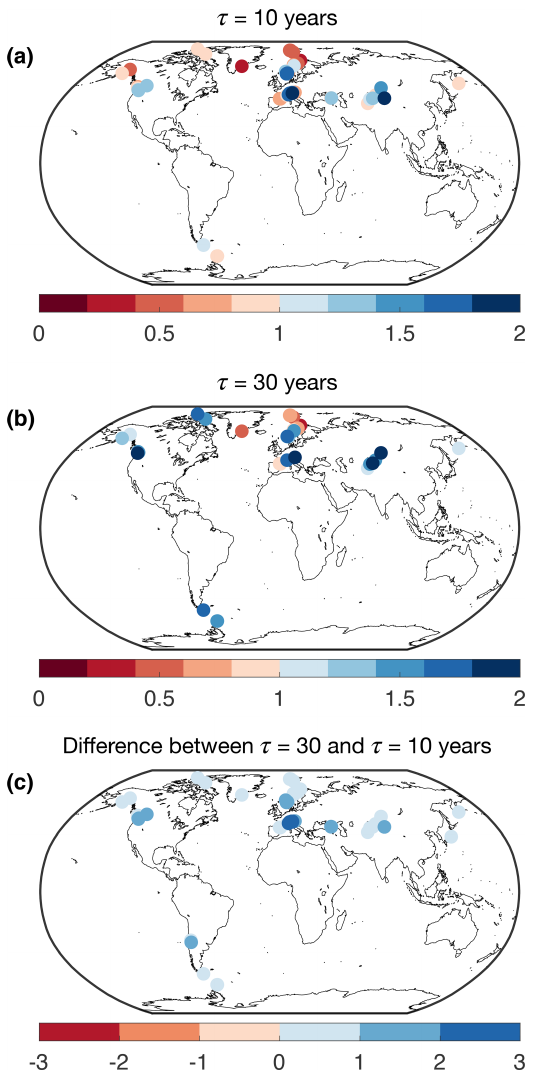
Figure A2. The signal-to-noise ratio (SNR) of glacier length for all 76 glacier locations given (a) τ = 10 years and (b) τ = 30 years. (c) The difference between panels (b) and (a) . Red colors in pan- els (a) and (b) indicate a larger role for internal variability than forced variability, while blue colors indicate the opposite. Blue col- ors in panel (c) indicate a greater role for forced variability when τ = 30 years than when τ = 10 years.